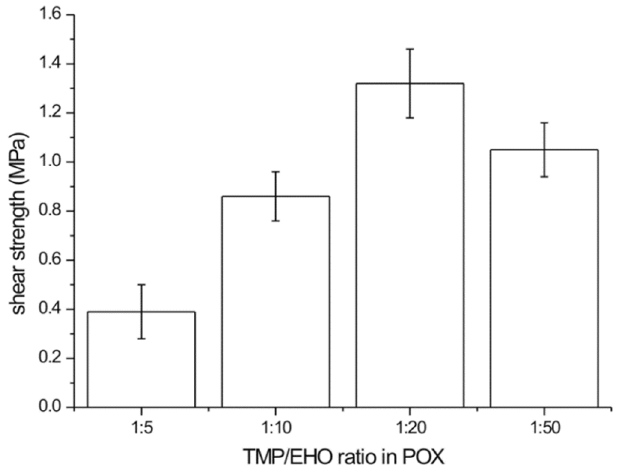
Figure 7. Shear strengths of the POX bond-lines.